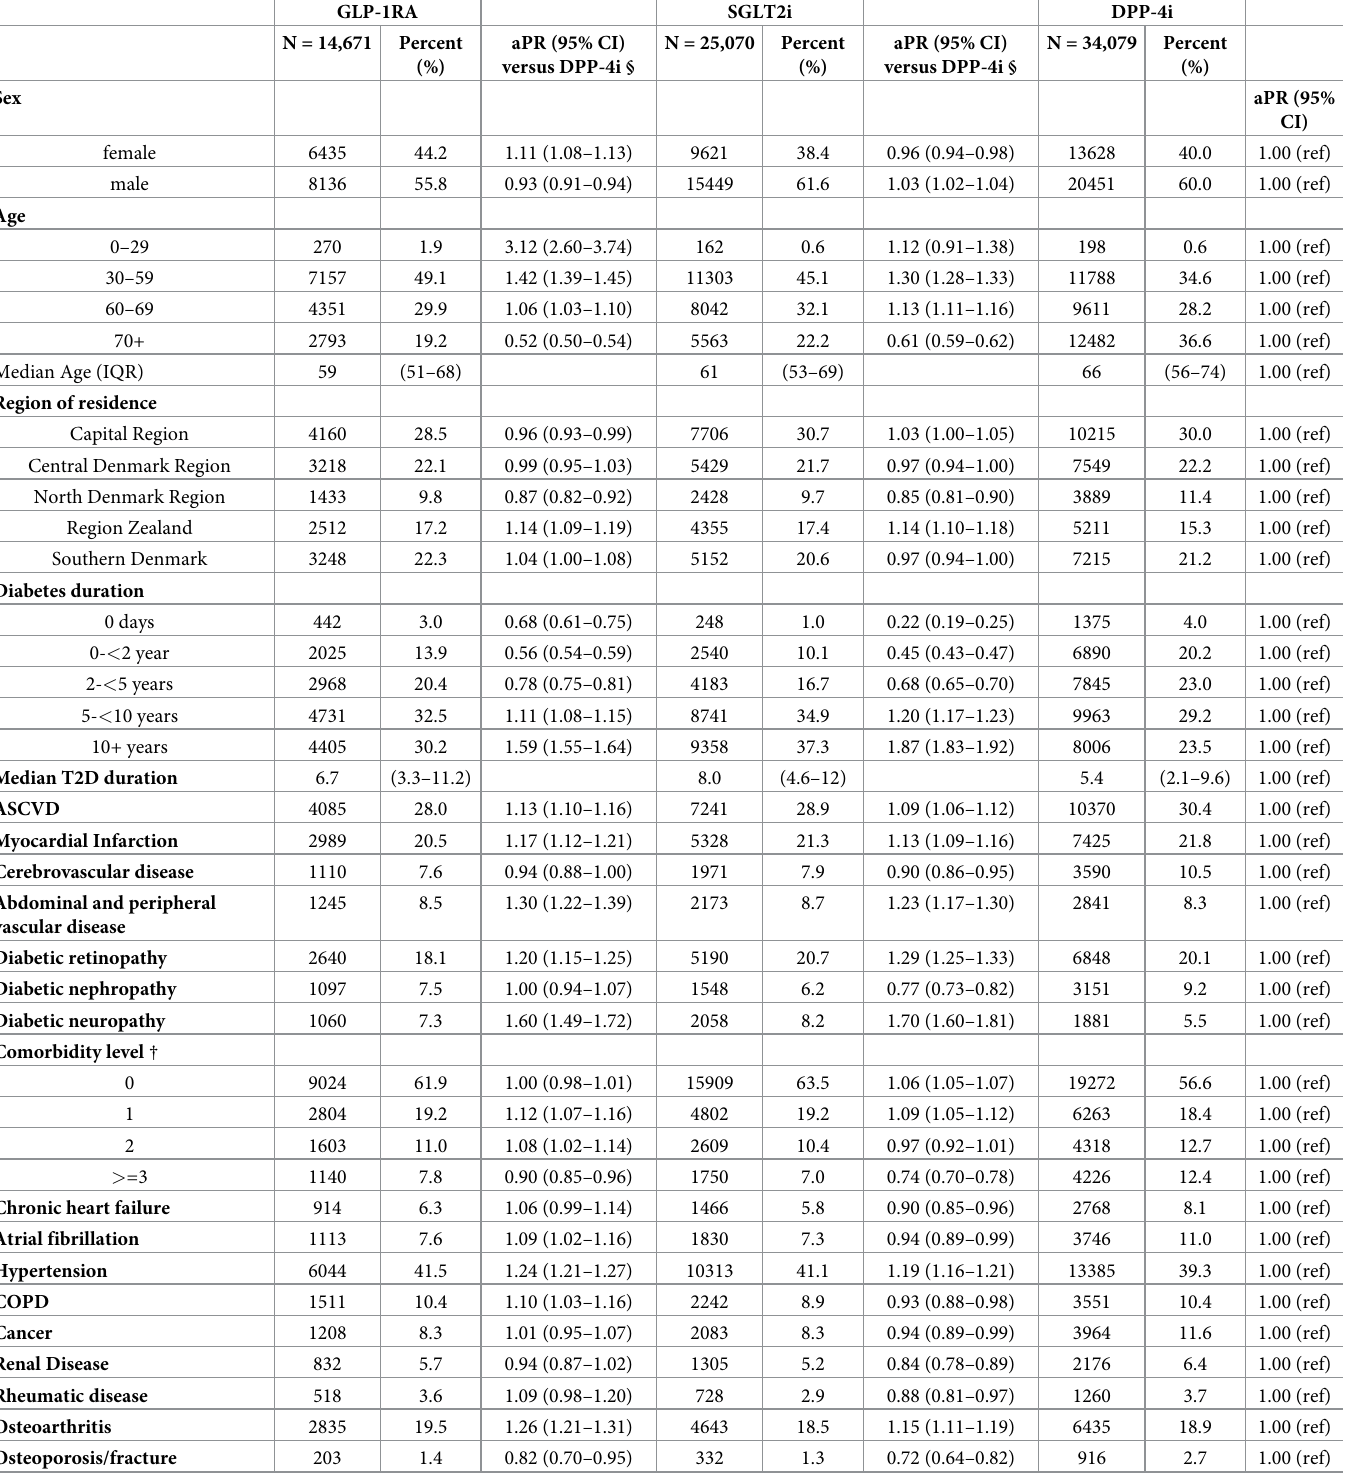
Table 1. Clinical characteristics among real-world initiators of GLP-1RA, SGLT2i and DPP-4i in Denmark,